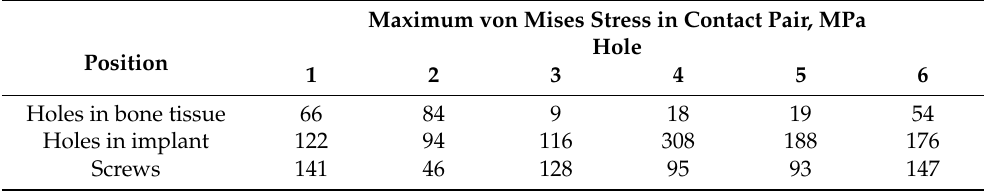
Table 3. Maximum von Mises stress in the system components with pretension force of 500 N.